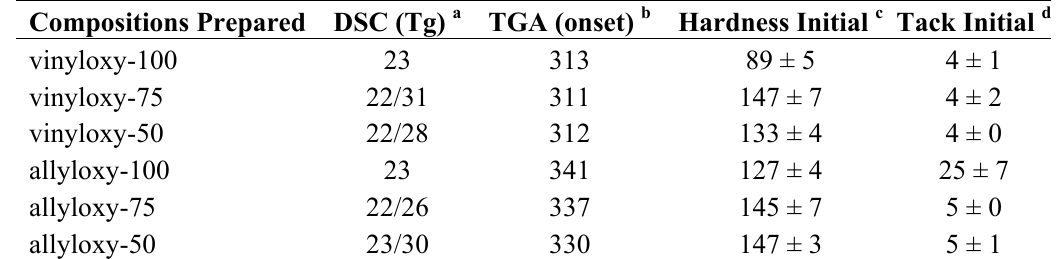
Table 2. Characterization of film samples for mechanical, thermal, and texture properties.